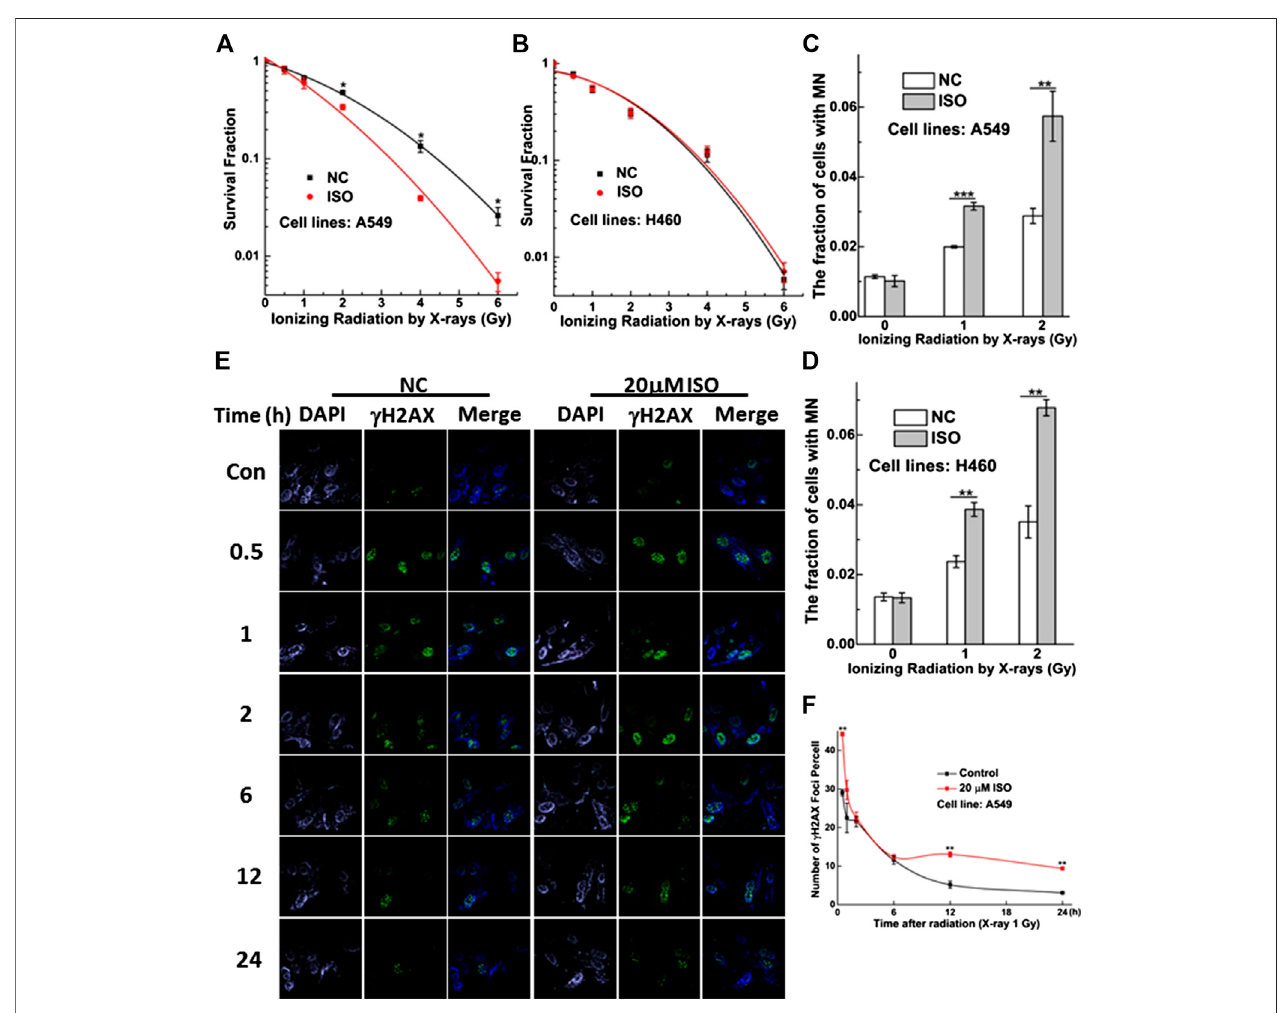
FIGURE 2 | ISO sensitized NSCLC cells to IR. Survivals measured by colony formation assay in A549 (A) and H460 (B) cells pretreated with/without ISO and followed by 0, 0.5, 1, 2, 4, and 6 Gy X-rays irradiation. The fraction of MN in A549 (C) and H460 (D) cells pretreated with/without ISO and followed by 0, 1, and 2 Gy X-rays irradiation. Five hundred cells were scored under microscopy to determine the frequency of cell with micronuclei. Representative images of γ H2AX foci (green) in A549 (E) and H460 (G) cells pretreated with/without 20 μ M ISO for 24 h and then exposed to 1 Gy X-rays, fi xed at different time points, and detected by immuno fl uorescence staining assay. The numbers of γ H2AX foci in 100 cells of each group were counted at each time point in A549 (F) and H460 (H) cells. Each data point represents the mean of three separate experiments. * p < 0.05, ** p < 0.01, *** p < 0.001 vs. non-drug-treated cells.